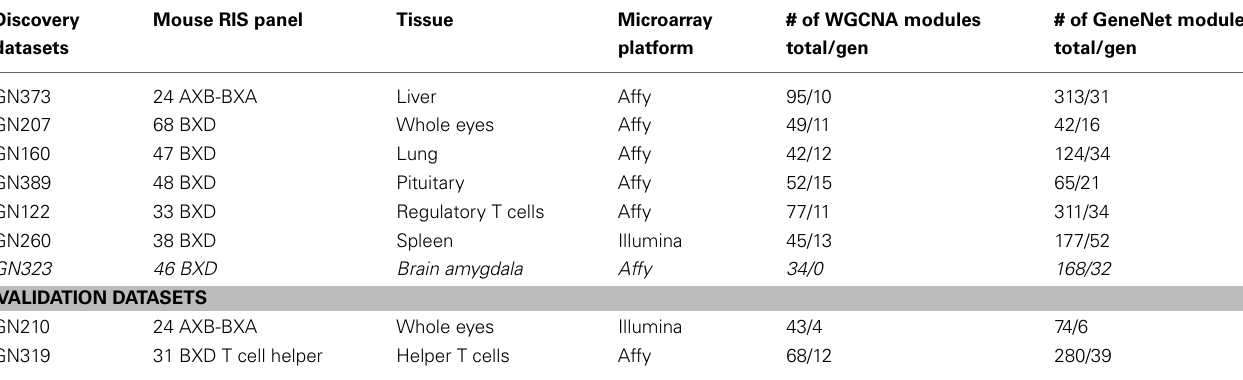
Table 1 | Gene expression datasets from tissues of mouse RIS used for either discovery or validation analyses in the present study. Discovery